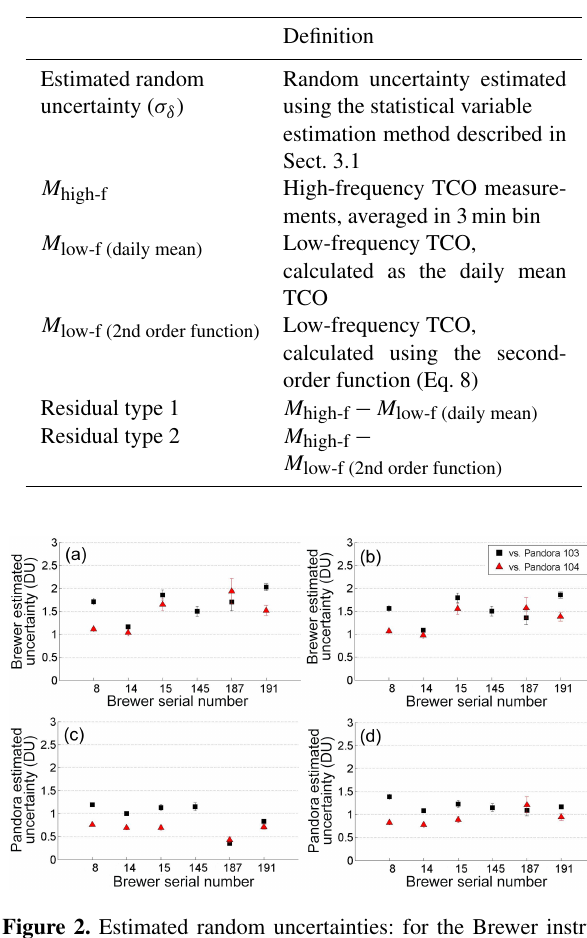
Figure 2. Estimated random uncertainties: for the Brewer instru- ments using (a) residual ozone type 1 and (b) residual ozone type 2; for the Pandora instruments using (c) residual ozone type 1 and (d) residual ozone type 2. The black squares indicate data from Pandora no. 103, and the red triangles indicate data from Pandora no. 104. The error bars show the 95% confidence